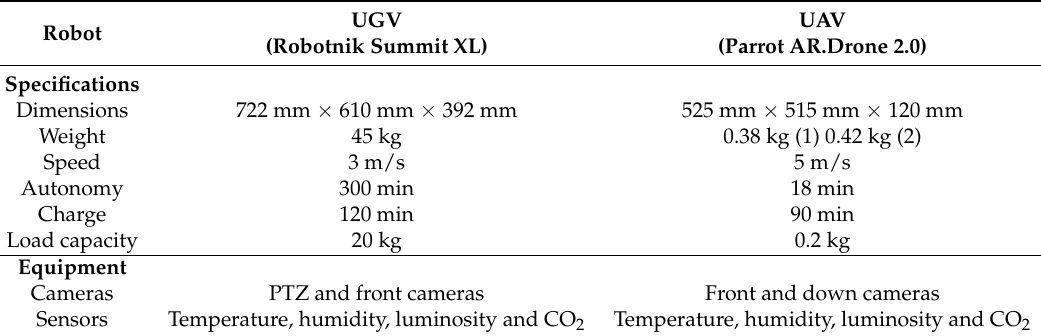
Table 2. Comparison among ground and aerial